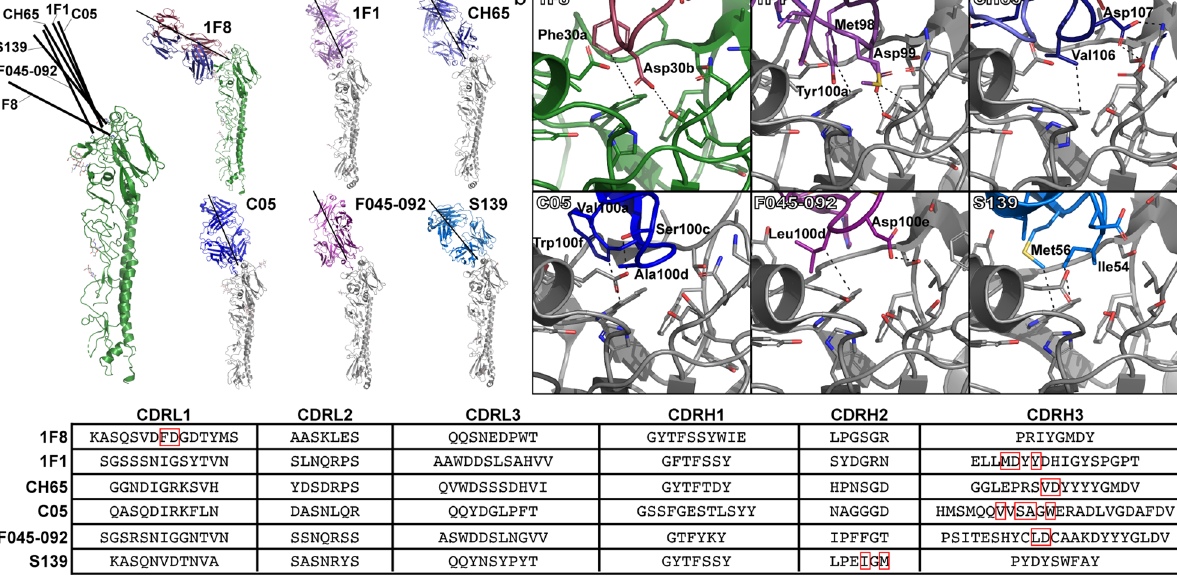
Fig. 7 Comparison of 1F8 with other known RBS antibodies. a Overall view of the COBRA P1-1F8 mode of binding compared to antibodies 1F1 (PDB 4GXU), CH65 (PDB 5UGY), C05 (6ML8), F045-092 (PDB 4O58), and S139 (PDB 4GMS). Each structure is depicted as a single monomer bound to Fab, with line segments added to illustrate the relative orientations of the antibodies upon binding. b Closeup views of the RBS interactions for each antibody, with key contacts indicated by black dashed lines. c Complementarity Determining Regions of each antibody assigned according to the Chothia numbering system (annotated using the AbRSA server 80 ). Residues forming important contacts within the RBS are boxed in red. COMMUNICATIONS BIOLOGY| (2023) 6:454